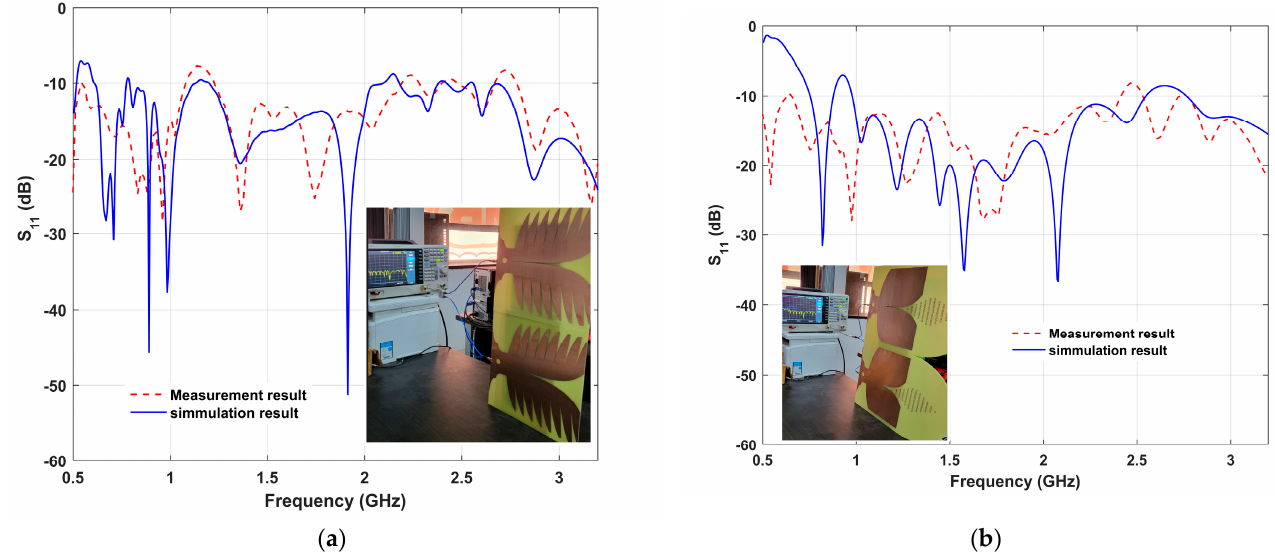
Figure 14. Simulation and measurement result of ( a ) ESEPT – CVA and ( b ) MLPT – CVA.